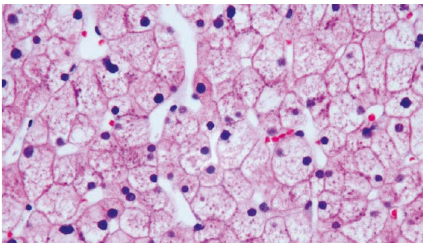
Figure 1: Diffuse hepatocyte enlargement with pale cytoplasm and prominent cytoplasmic membranes. There is a mosaic appearance of the parenchyma due to the compression of sinusoids, resulting in a sheet-like appearance of the hepatocyte architecture. There is no inflammation or